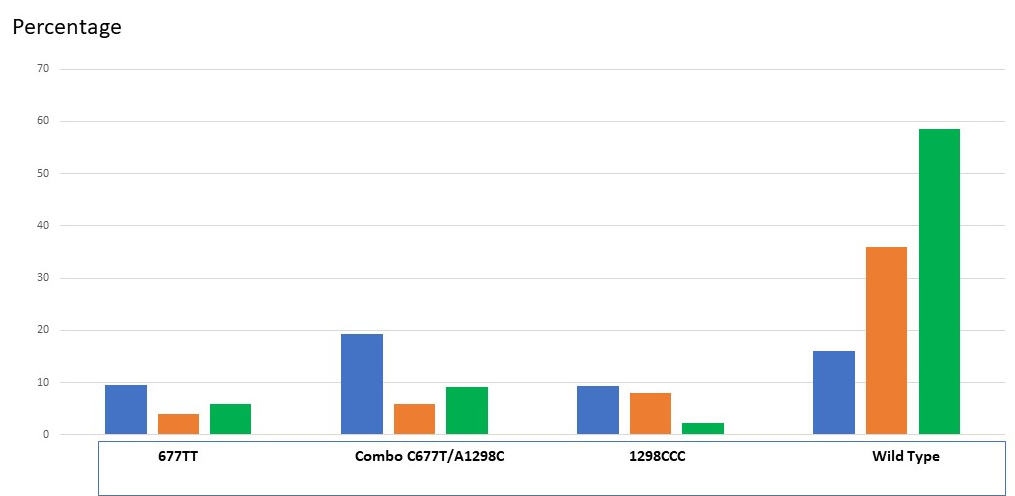
Figure 4. Percentage of the MTHFR C677T and A1298C in our hypo-fertile population (women). Dark blue: hypo-fertile population of various etiologies (1500 women, [10]). Orange: control fertile population (100 patients [49], green, control fertile population (200 patients [48]). Combo: compound heterozygous: C677T/A1298C.